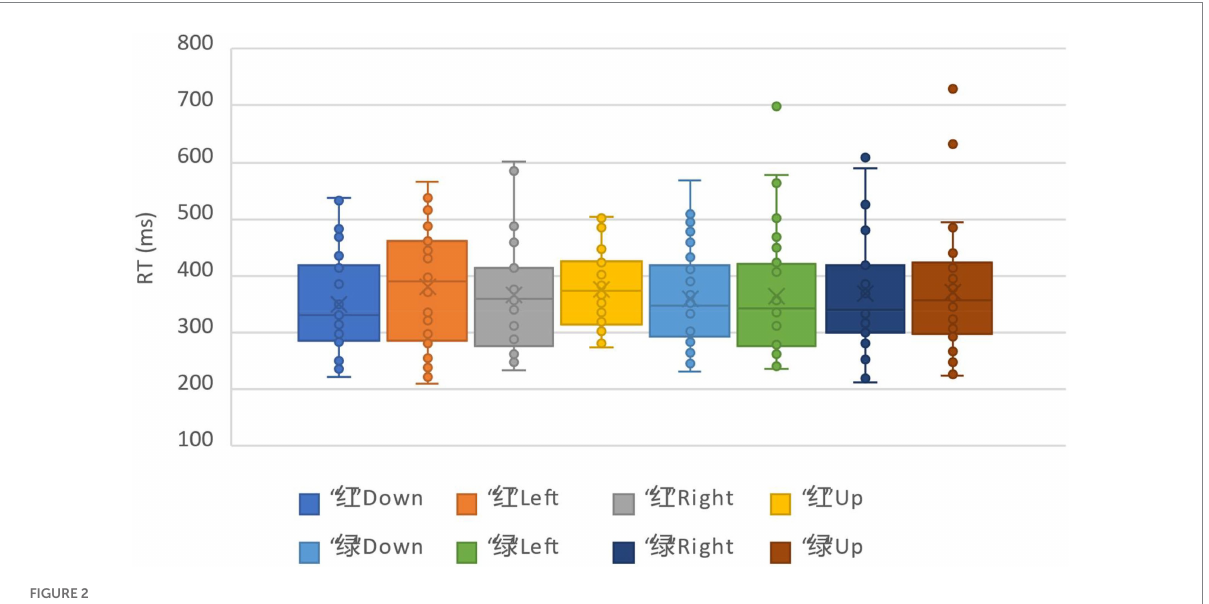
FIGURE 2 The data distribution of all participants under all conditions in pre-experiment.